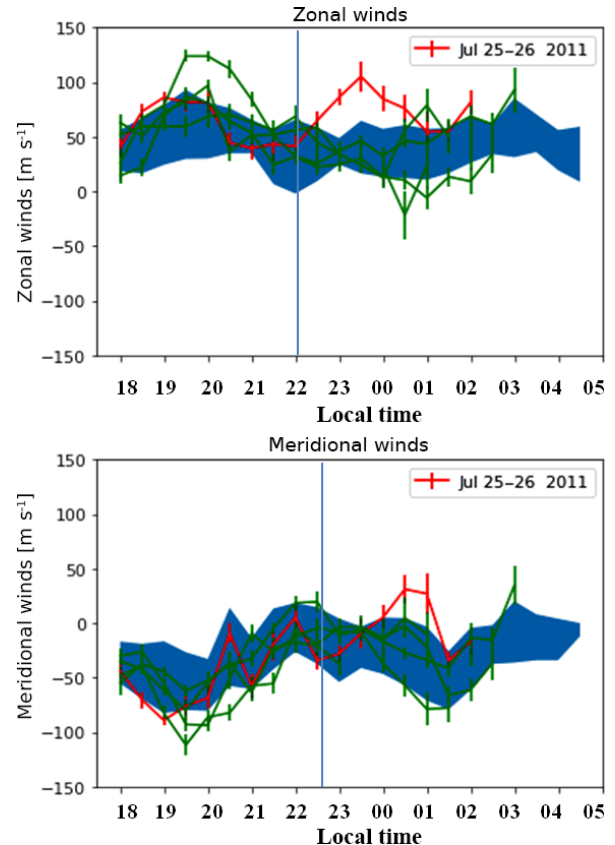
Figure 8. Measured zonal and meridional winds in CZ, Brazil, on 25–26 July 2011. The shaded region is the monthly average with standard deviation; the green lines are the mean winds on 25– 26 July (mean of 2d), and the red line is for 25–26